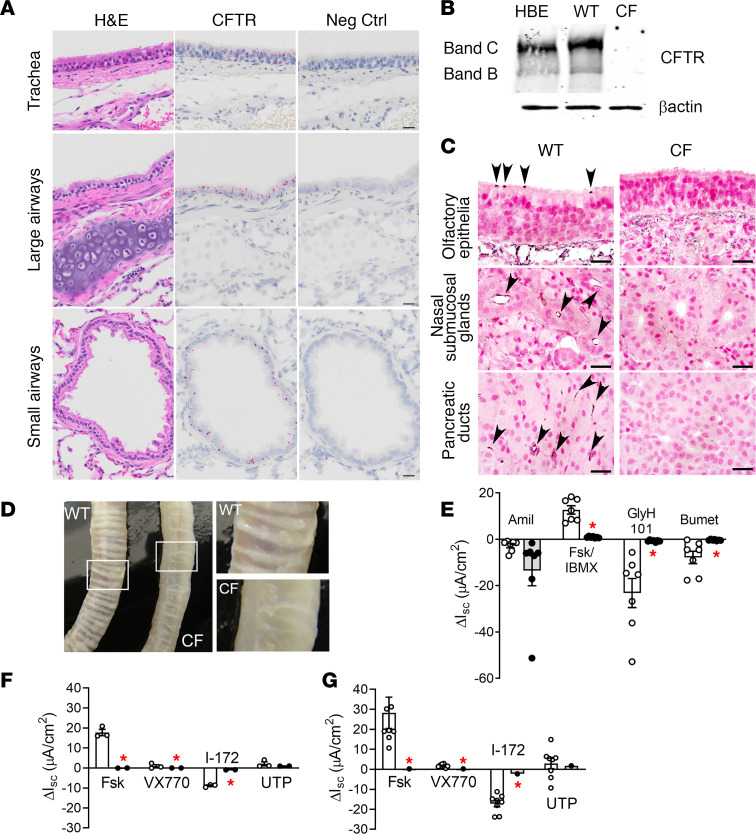
Characterization of rabbit CFTR expression and function in the lower airways.(A) Representative micrographs of trachea, large bronchi, and small airways (bronchiole) from WT rabbits (approximately 3 months old), stained with H&E or probed for CFTR and negative control mRNA by RNAscope (red chromogen). Scale bar: 20 μm. n = 2 rabbits. (B) CFTR Western blots for normal human bronchial epithelial (HBE) cell cultures alongside tracheal tissue lysates from WT and CF rabbits (Δ1 line). Position of band B and C are indicated, and Western blot for β actin is shown as loading control. (C) IHC for CFTR in nasal olfactory epithelia, nasal submucosal glands, and pancreas, where CFTR (black chromogen, arrowheads) was detected in cells consistent with the distribution of ionocytes, ductal cells, and collecting ducts, respectively. Scale bar: 20 μm. (D) Gross images of tracheas isolated from WT and CF rabbits. CF tracheas lack concentric and equally spaced cartilaginous rings compared with WT rabbits. (E) Ussing chamber measurements of short-circuit currents (Isc) in freshly excised WT and CF rabbit tracheas. Isc changes in response to amiloride (amil), forskolin/IBMX (Fsk/IBMX), GlyH101 (Gly101), and bumetanide (Bumet) are shown. Basal Isc and transepithelial resistance were 49.82 ± 14.23 versus 57.74 ± 2.52 μA/cm2 and 60.07 ± 13.7 versus 60.66 ± 11.4 Ωcm2 for WT versus CF rabbits, respectively. n = 7 WT and 7 CF rabbits. *P < 0.05 versus WT rabbits. Unpaired, 2-tailed t test with Welch’s correction for unequal variance. (F and G) Ussing chamber measurements of Isc for WT and CF rabbit tracheal epithelial cell cultures (F) (WT n = 3 and CF n = 2, 3–4 inserts/code), and normal and CF human bronchial epithelial cell cultures (G) (NL [n = 5] and CF [n = 1], 1717 1-G>A/N1303K compound mutation, no CFTR protein detectable, 3–4 inserts/code), illustrating responses to forskolin (Fsk), Vertex 770 (VX770), CFTR inhibitor 172 (I-172), and uridine triphosphate (UTP). *P < 0.05 versus WT cultures. Each dot represents the average of 3–4 inserts measurements. Unpaired, 2-tailed t test with Welch’s correction for unequal variance.